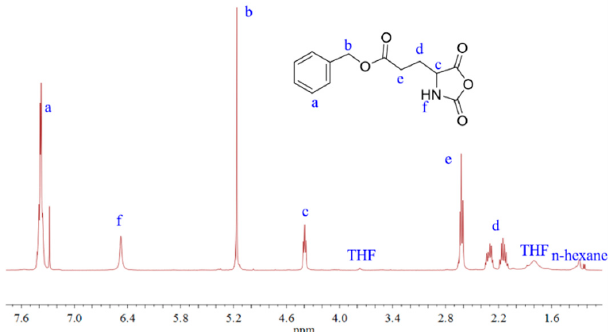
Figure 1. 1 H Nuclear Magnetic Resonance (NMR) spectrum of γ -Benzyl- L -glutamate- N